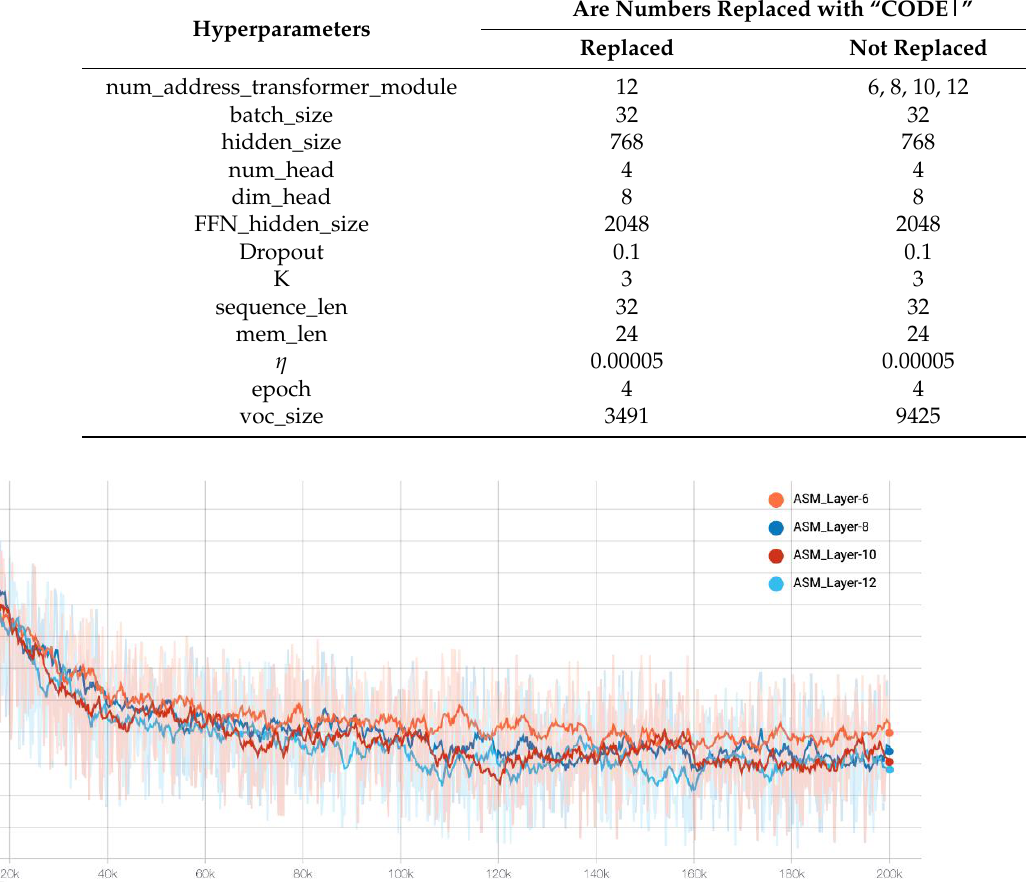
Figure 3. Comparison of training loss gradient curves for the ASM with a different number of address-transformer modules, where the curve smoothness is set to 0.9, and the opaque curve is after the smoothing setting and the translucent curve is the original loss gradient curve. Table 4. Values for the ASM indicator for a different number of address-transformer modules.